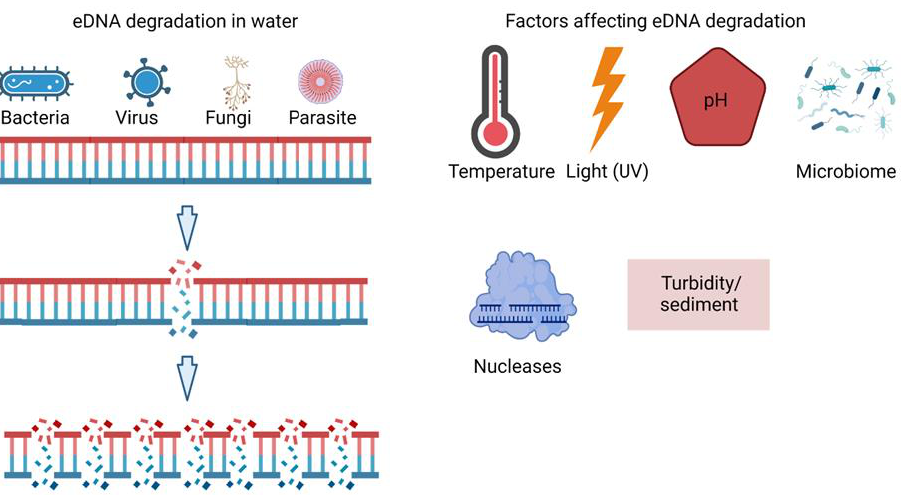
Figure 2. Different factors affecting nucleic acid degradation in the aquatic environment. Nucleic acids are affected by temperature, light, pH, and the environment they are present in.